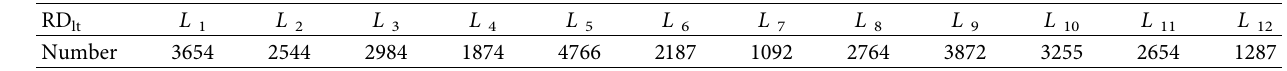
Table 5: The number of recycled wastes (worn-out valves) of each sold